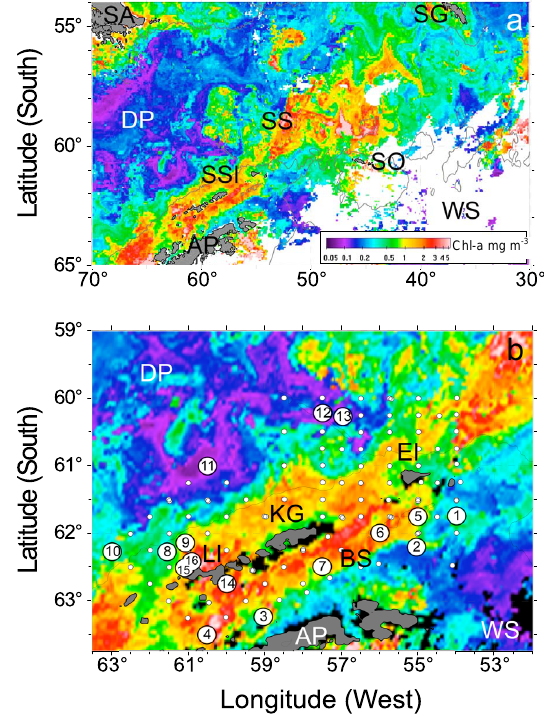
Fig. 1. Satellite images showing mean chlorophyll- a concentrations (mgm − 3 ) of surface waters in the Drake Passage-Scotia Sea re- gions of the Southern Ocean during January, 2006. The color bar in the top image applies to both images. (a) Large scale map showing high chlorophyll- a concentrations in the central Scotia Sea down- stream of the South Shetland Islands region. (b) Antarctic Penin- sula region, with the numbered white circles showing location of stations where Fe concentrations were determined. Numbers refer to the stations listed in Table 2 that also provides hydrographic and biological data. The small white circles show the locations of all the stations in the AMLR sampling grid. The thin continuous line in (a) and (b) is the 1000m depth isobath. AP, Antarctic Peninsula; DP, Drake Passage; EI, Elephant Island; KG, King George Island; LI, Livingston Island; SA, South America; SO, South Orkney Islands; SS, Scotia Sea; SG, South Georgia; SSI, South Shetland Islands; WS, Weddell Sea. White areas indicate no data due to cloud or ice